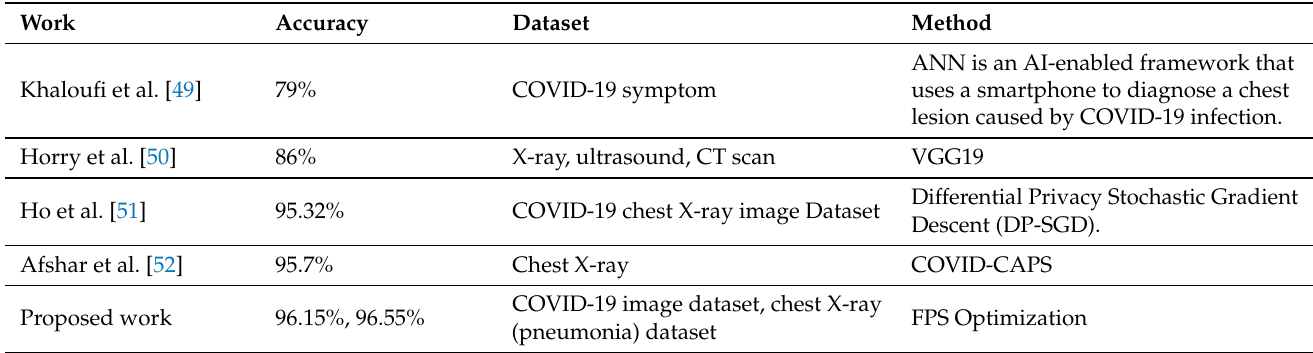
Table 7. Comparison of the proposed model with recent